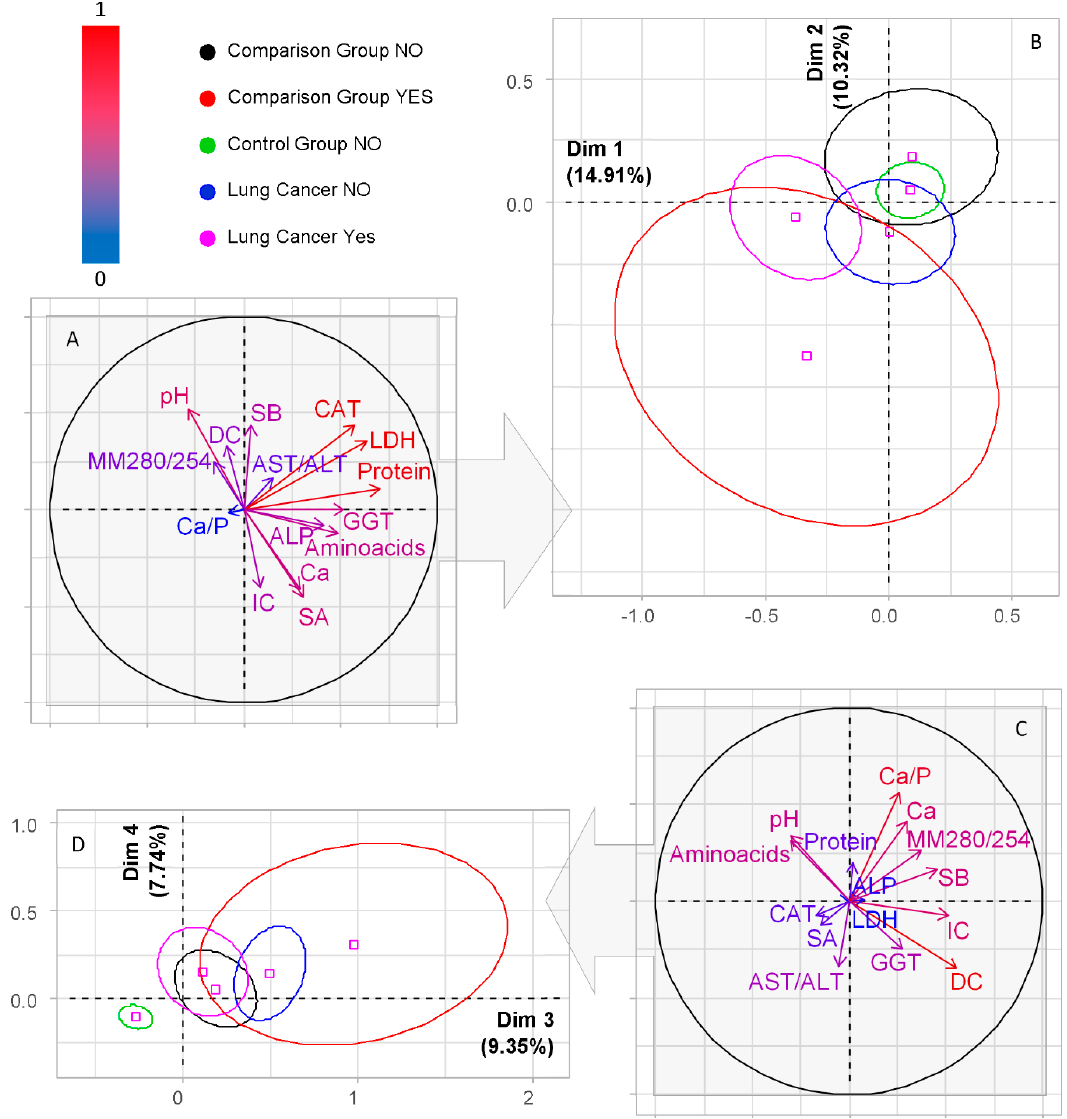
Figure 3. PCA—Factor plane ( B , D ) and the corresponding correlation circle ( A , C ) in the first four dimensions for five groups (control, lung cancer without COPD, lung cancer with COPD, comparison group without COPD, comparison group with COPD). The color of the arrows on the correlation circle changes from blue (weak correlation) to red (strong correlation), as shown on the color bar. The orientation of the arrows characterizes positive and negative correlations (for the first principal component, we analyze the location of the arrows relative to the vertical axis, for the second principal component-relative to the horizontal axis). LDH—lactate dehydrogenase; CAT—catalase; SB—Schiff bases; DC—diene conjugates; SA—sialic acids; Ca—calcium; Mg—magnesium; Ca/P—calcium to